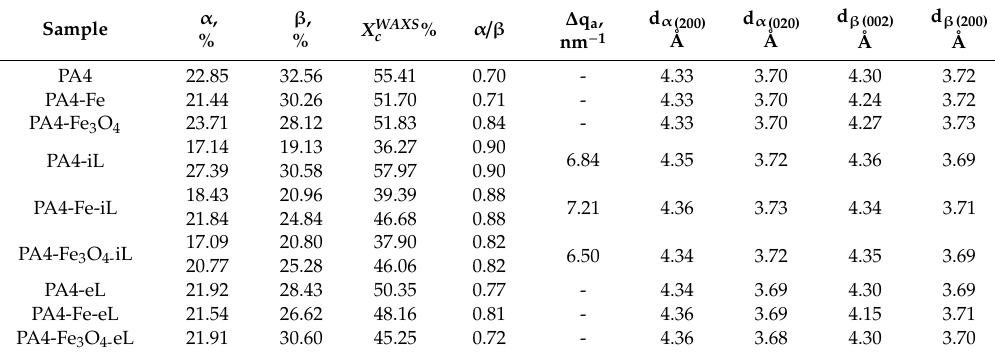
Table 6. WAXS analysis of empty PA4 supports and PA4-laccase